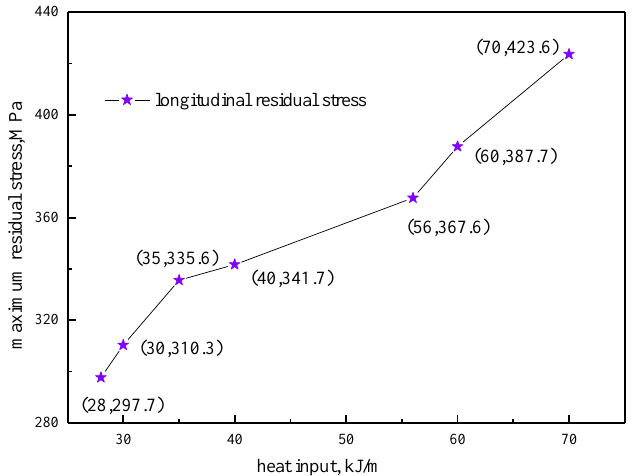
Figure 9. The relationship between maximum longitudinal residual stress and heat input. Three approximate linear stages are presented and the maximum residual stress changes slowly in the second stage.